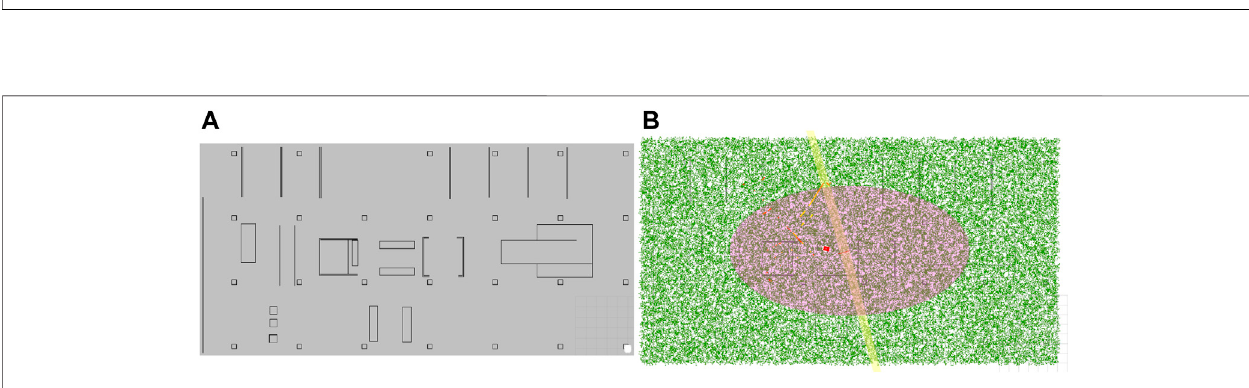
FIGURE 9 | (A) The grid map containing the static geometry as generated for AMCL localization. (B) The initial particle spread in AMCL, consisting of 50,000